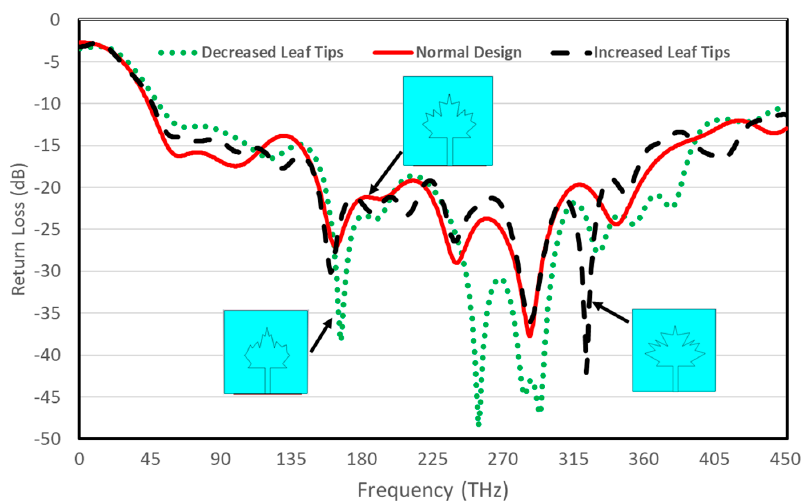
Figure 7. Performance comparison for different lengths of the leaf tips with the maple-leaf antenna geometry shown as an inset.